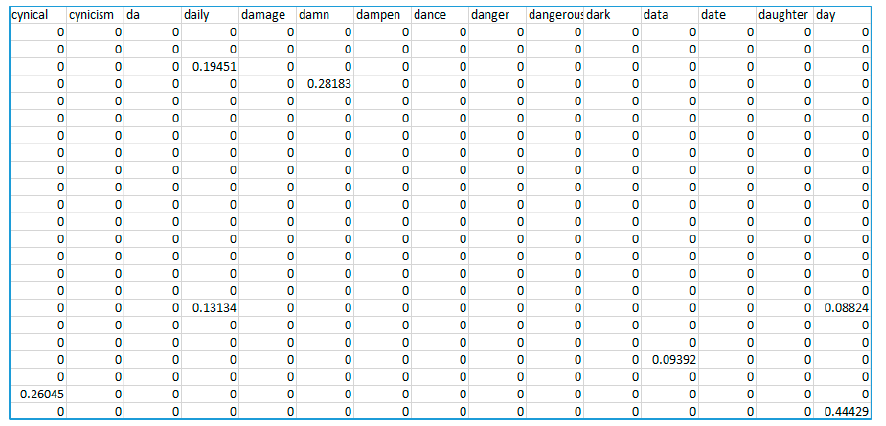
Figure 10. An excerpt from the vectorized dataset.